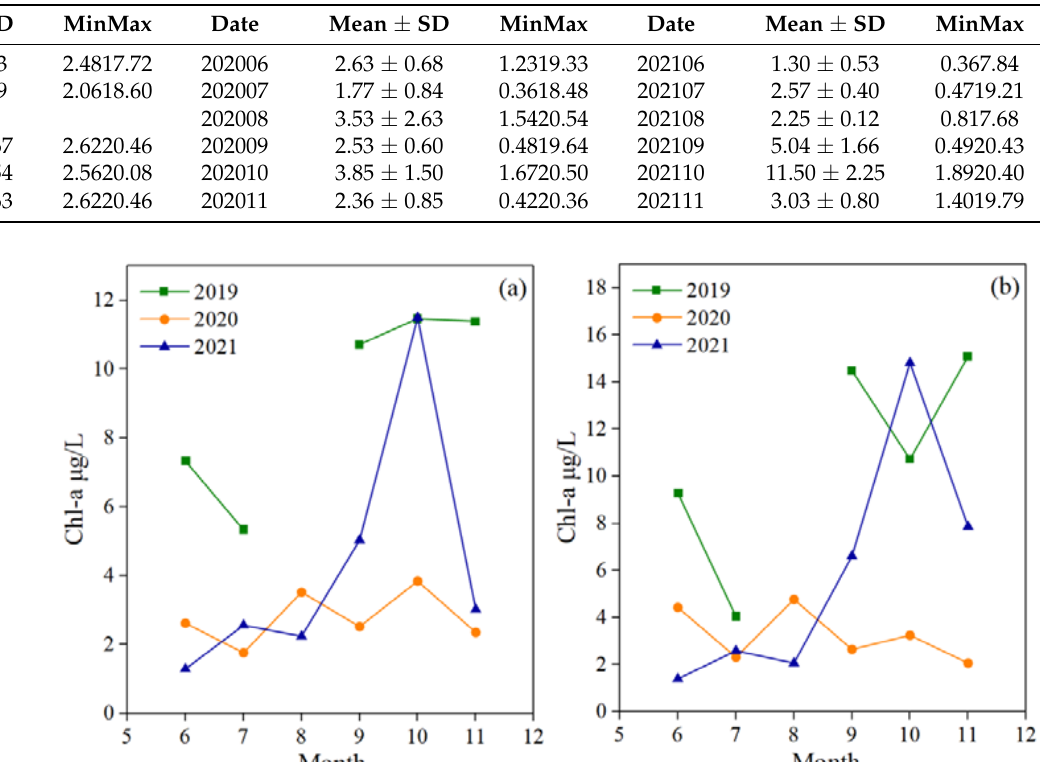
Table 3. Mean, maximum, minimum, and standard deviation of Chl-a concentration (unit: μg/L) in GF-6 WFV images of Da Xingkai Lake.